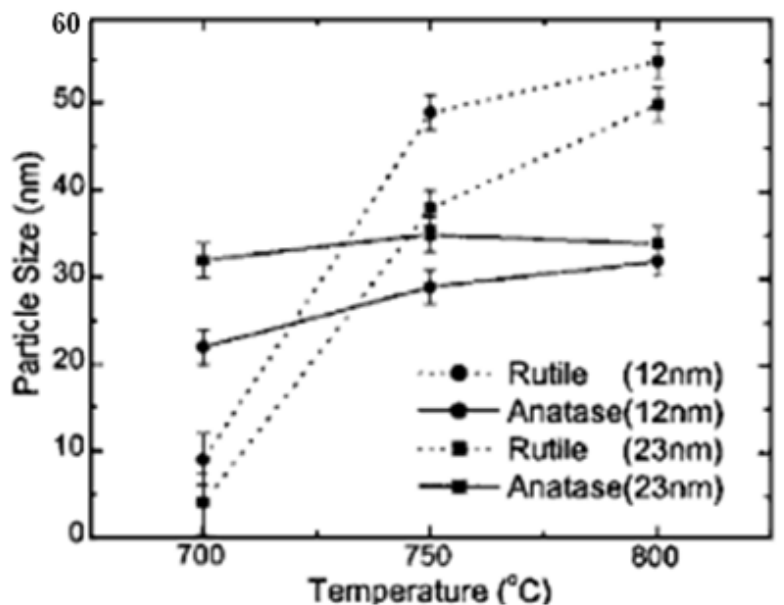
Figure 8. Changes in the particle size of anatase and rutile as a function of annealing temperature [158].